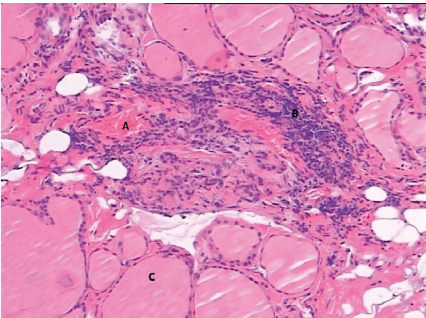
Figure 3: The appearance of histopathology (HE, × 100). Under the light microscope, the thyroid histopathological sections with HE staining. (A) The area of the hemorrhage cavity after pulling out the fish bone. (B) The well-defined region composed of macrophages and inflammatory cells in accordance with classic foreign body granulomatous inflammation. (C) Normal thyroid